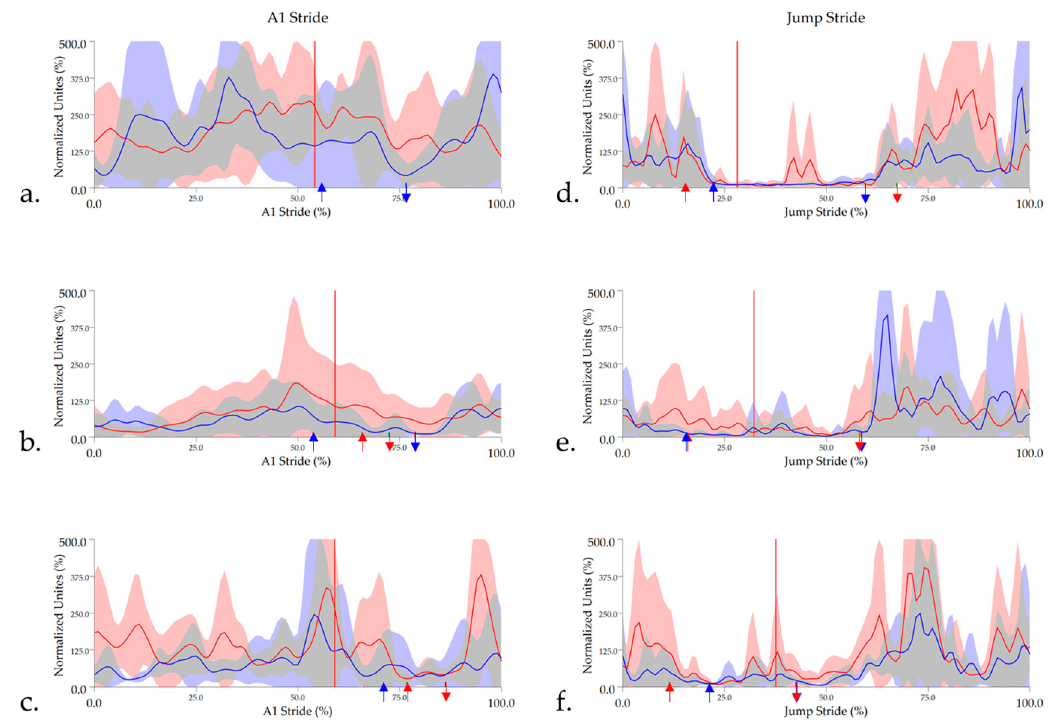
Figure 8. Mean and standard deviation time and amplitude-normalized, linear enveloped sEMG signals for triceps in ( a ) High CM , ( b ) Int CM , and ( c ) Low CM horses during A1 stride and ( d ) High CM , ( e ) Int CM , and ( f ) Low CM during jump stride. sEMG signals are DC-offset, high-pass filtered (40 Hz cut-off) and low-pass filtered (25 Hz). Mean data are presented for leading forelimb (LdF) (red line) and trailing forelimb (TrF) (blue line), with shaded areas representing the standard deviation for each limb. Arrows represent the mean triceps activity onset (downward arrows) and offset (upward arrows) events for LdF (red arrows) and TrF (blue arrows). Red vertical lines represent the average hindlimb lift-off event within each group.